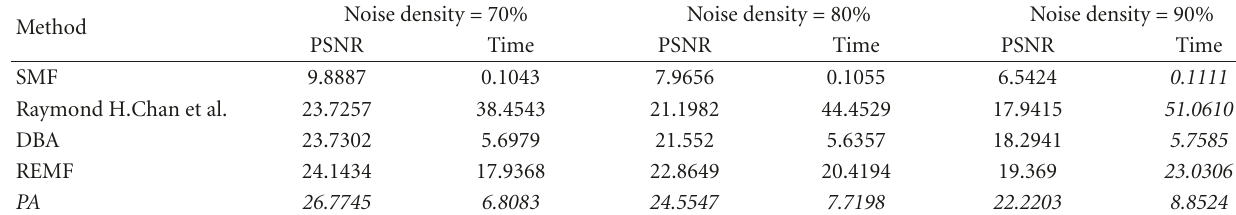
Table 7: Comparison of PSNR and CPU time in seconds for cameraman image.